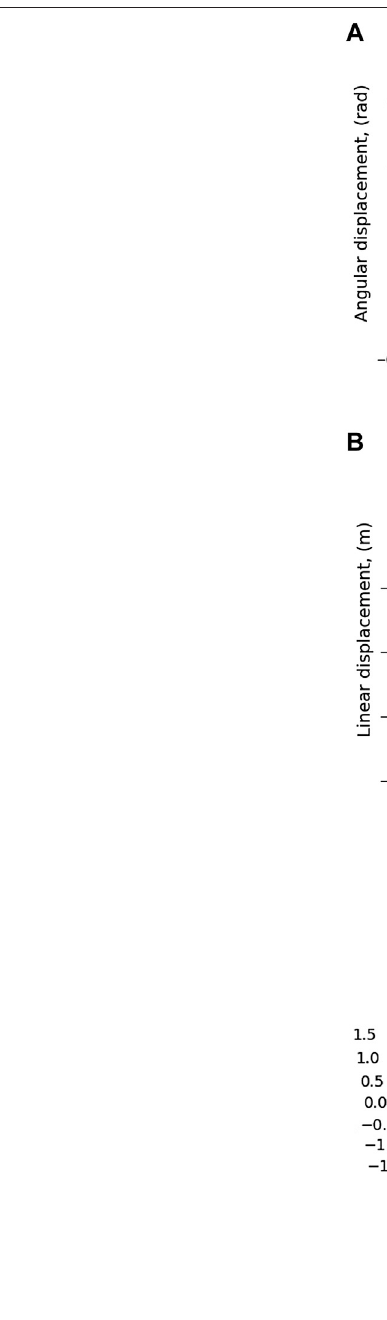
Algorithm 1: Algorithm for fi nding optimal trajectory using imitation learning